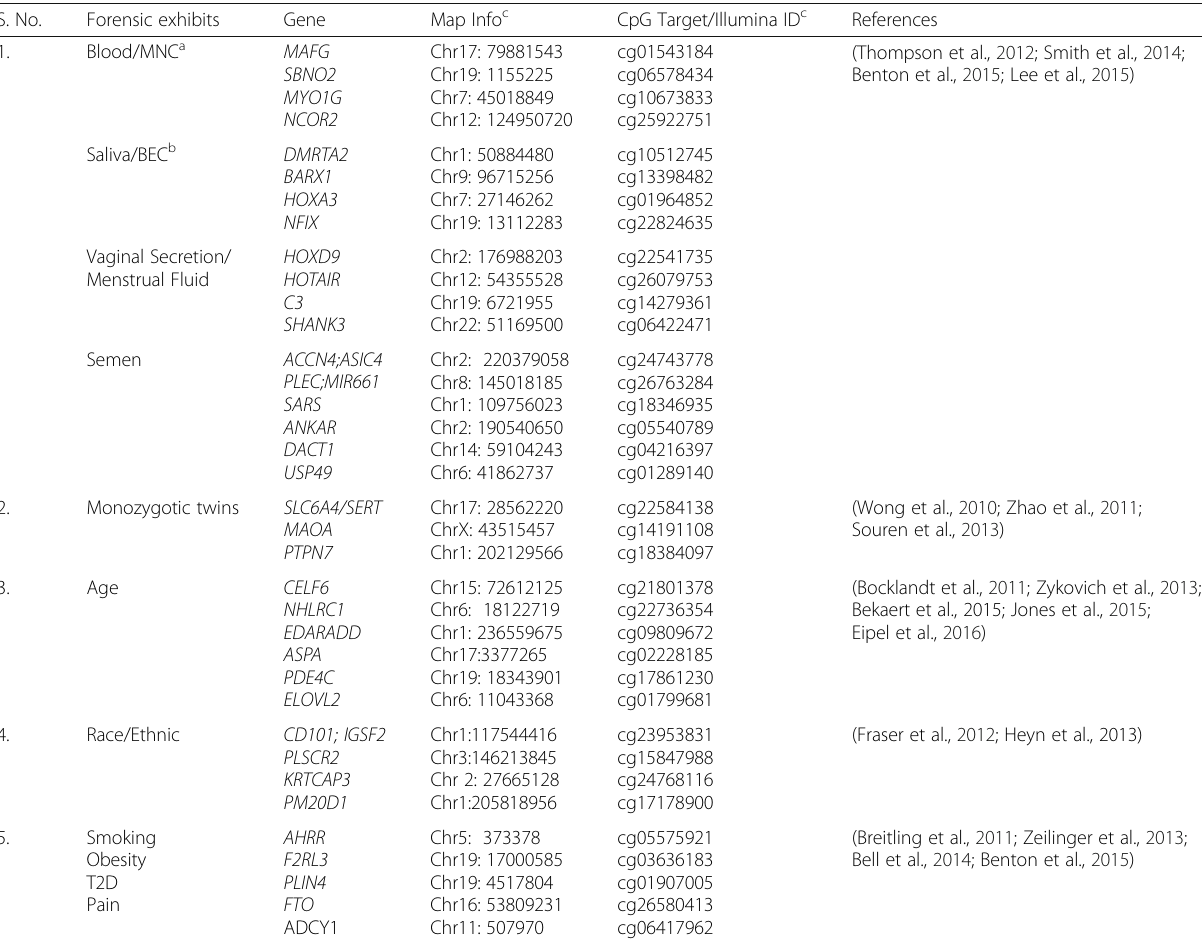
Table 2 Forensic exhibits and some epigenetic markers (CpG) information available using Illumina Infinium HumanMethylation450 BeadChip